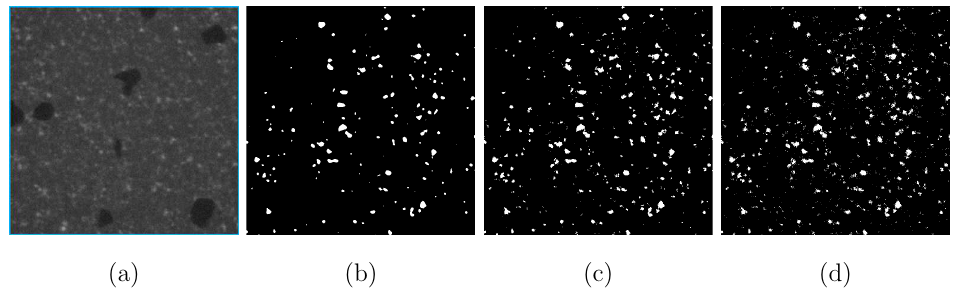
Fig. 11: (a) An original CT image with noise noises after the extraction of the inscribed square out of a Figure 11. ( a ) An original CT image with noises after the extraction of the inscribed square out of a circle; (b)-(d): final denoising results for of the WC phase by using median, Gaussian, bilateral denoising circle; ( b – d ): final denoising results of the WC phase using median, Gaussian, bilateral denoising methods [61], respectively. methods [61],